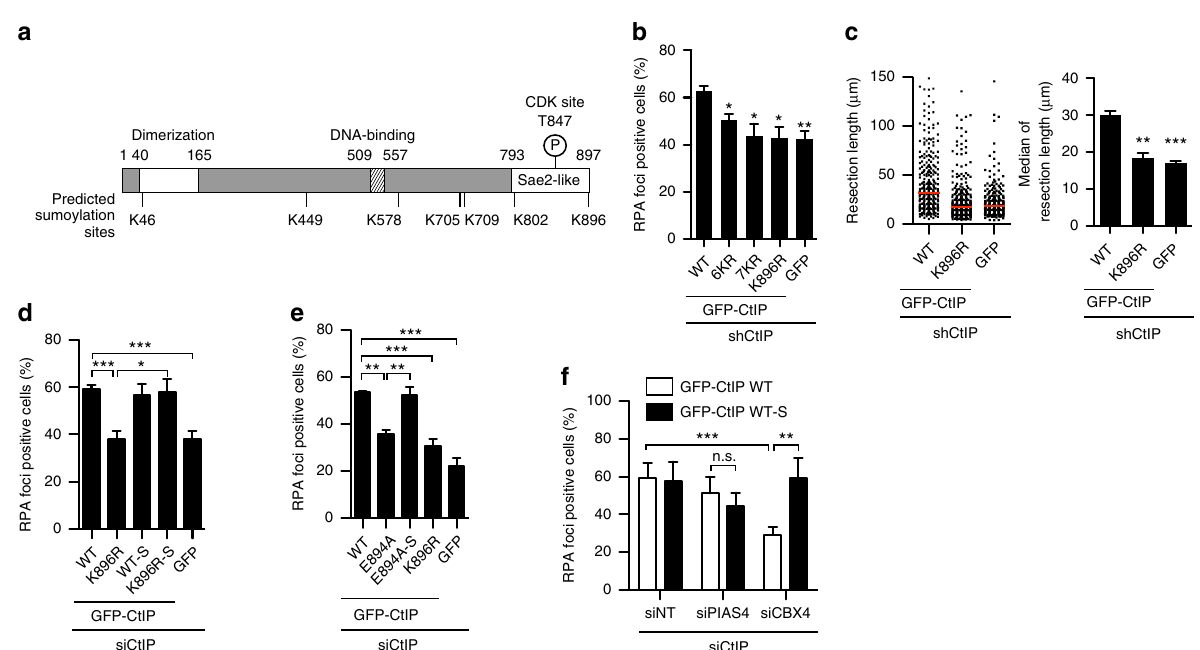
Fig. 3 Sumoylation of K896 in CtIP is essential for DNA resection. a Diagram of human CtIP protein. The predicted sumoylation sites and the CDK-mediated phosphorylation site used in this study are depicted. b U2OS cells stably expressing the indicated variants of GFP-CtIP, or GFP as a control, and depleted of endogenous CtIP were irradiated with 10 Gy. RPA foci were detected 1 h after ionizing radiation. c Resection length measured with SMART assay using DNA fi bers extracted from U2OS downregulated for endogenous CtIP and expressing GFP-CtIP, GFP-CtIP-K896R or GFP as control. The length of at least 200 fi bers and the median length (in red ) of a representative experiment in each case are plotted in the left graph . The average and SEM of the median length in three independent experiments are plotted in the right graph . In b and c , Student ’ s t -test was performed in each condition compared to control. d Same as b but with cells expressing wild-type CtIP or the K896R mutant transcriptionally fused (WT-S and K896R-S) or not (WT, K896R) to SUMO1. e RPA foci formation was analyzed as in b and d , but in cells expressing the mutant E894A and its SUMO1 fusion (E894A-S). For c and d , one-way ANOVA was used to analyze signi fi cance. f Cells depleted for the indicated genes and expressing either GFP-CtIP or GFP-CtIP-SUMO1 were irradiated and RPA foci-positive cells was scored as in b . Values of RPA foci-positive cells were normalized to the percentage of S/G2 cells (Supplementary Fig. 6b), as in Fig. 1b. Statistically signi fi cant differences were analyzed using two-way ANOVA. For b – e , the average and SEM of at least three independent experiments were plotted. For all statistical analyses; * P < 0.5; ** P < 0.01; *** P <